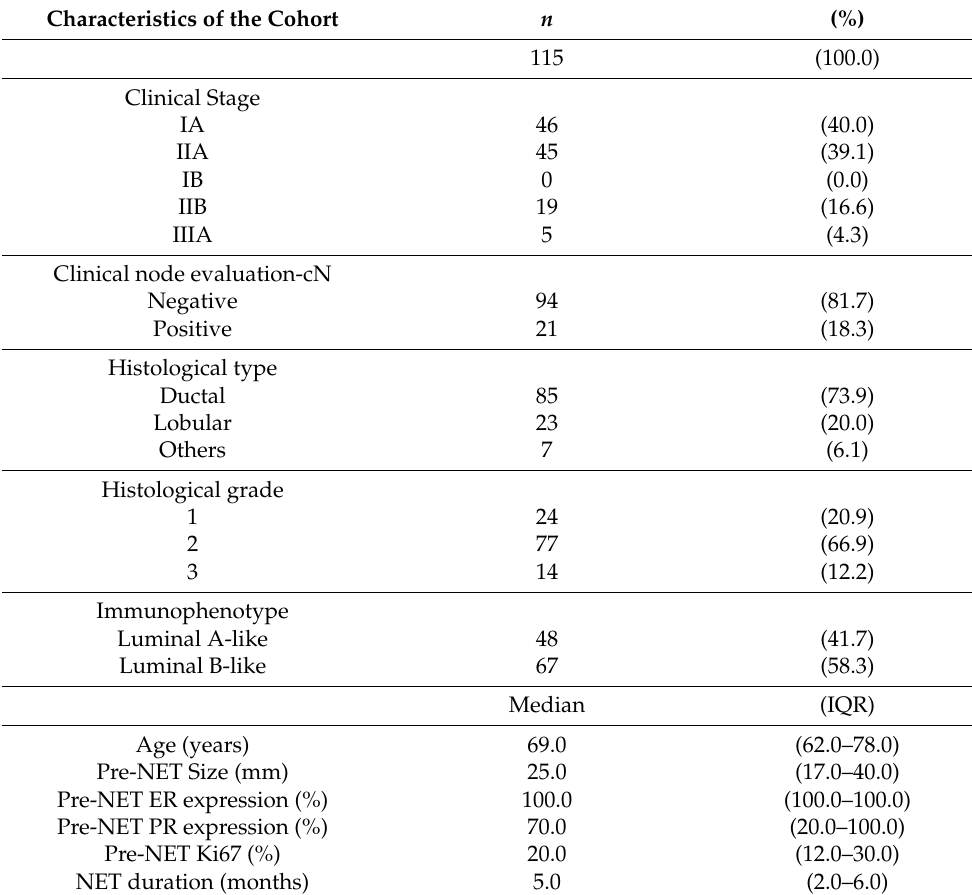
Table 1. Patient, tumor, and treatment